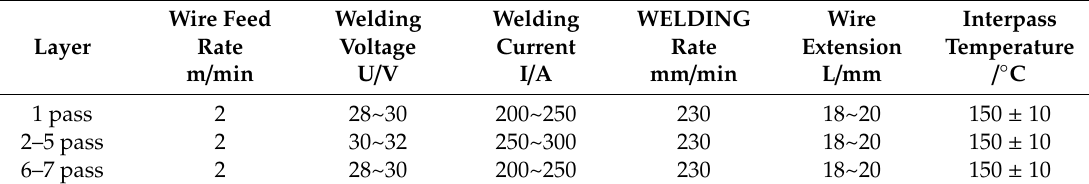
Table 6. Welding process parameters.